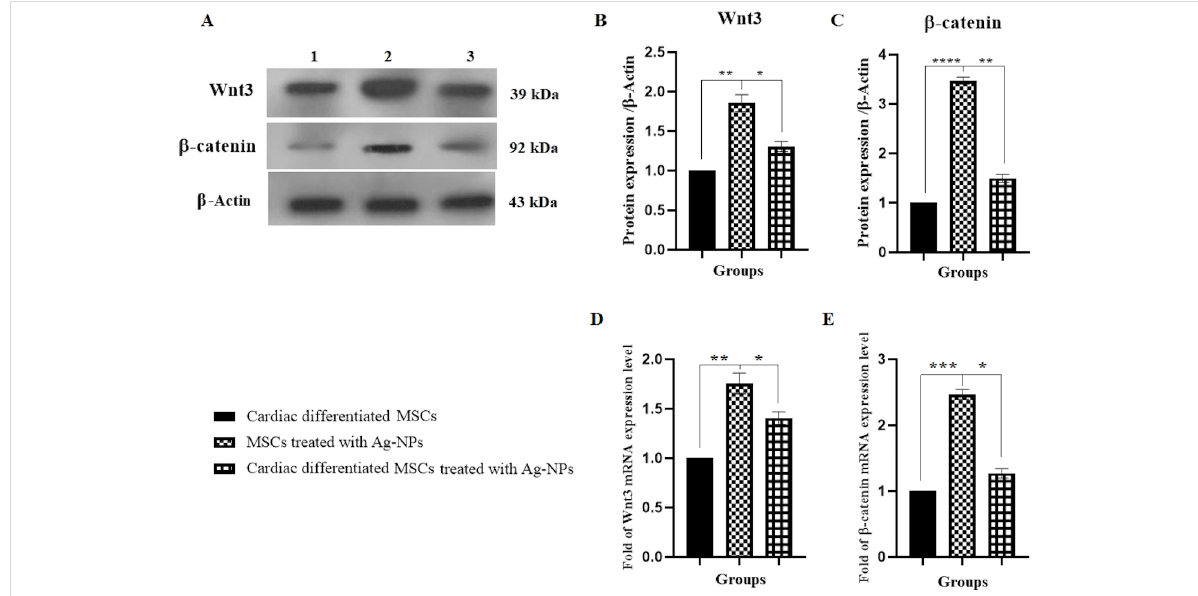
Figure 8: Effect of Ag-NPs on Wnt-3 and β -catenin protein and gene expression in cardiomyogenically differentiated BM-MSCs. (A–C) Protein and RNA were extracted from group I (cardiomyogenically differentiated BM-MSCs without Ag-NP treatment), group II (BM-MSCs in the presence of 2.5 µg/mL Ag-NPs), and III (cardiomyogenically differentiated BM-MSCs in the presence of 2.5 µg/mL Ag-NPs) as described in methods section and was subjected to western blotting; (* P < 0.05, ** P < 0.01 and **** P < 0.0001) and real-time PCR (D and E); (* P < 0.05, ** P < 0.01, and *** P < 0.001),